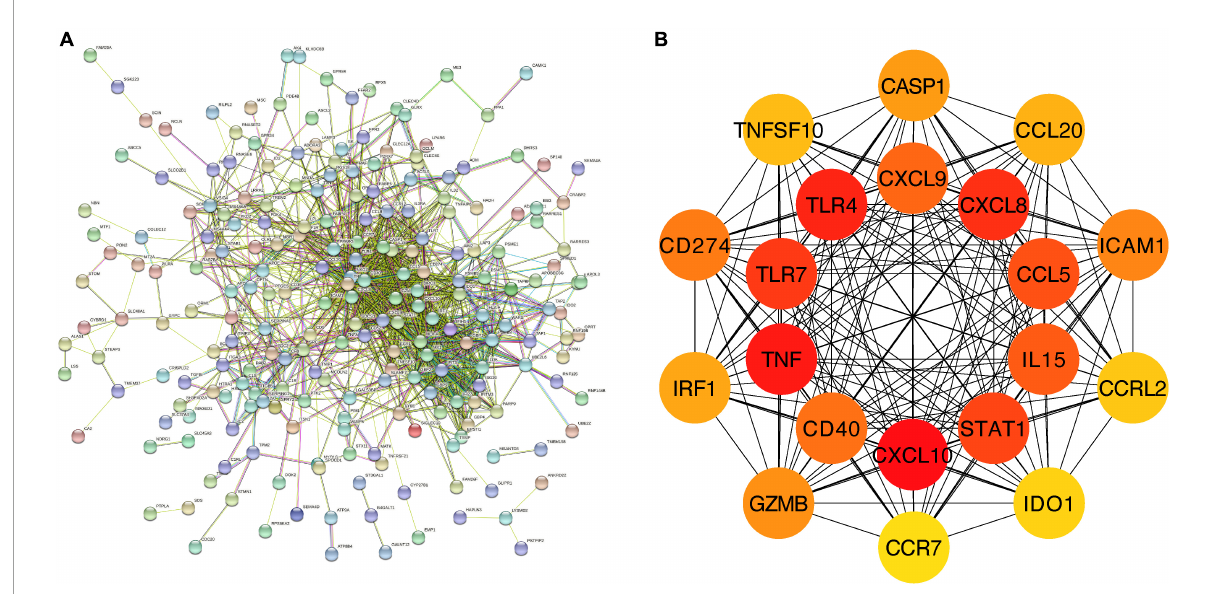
FIGURE3 PPI network and hub genes of the overlapping DEGs. (A) The interaction between 277 overlapping DEGs. Minimum required interaction score = 0.4, 276 nodes and 1,107 edges were included in the PPI network. (B) Top 20 hub genes.